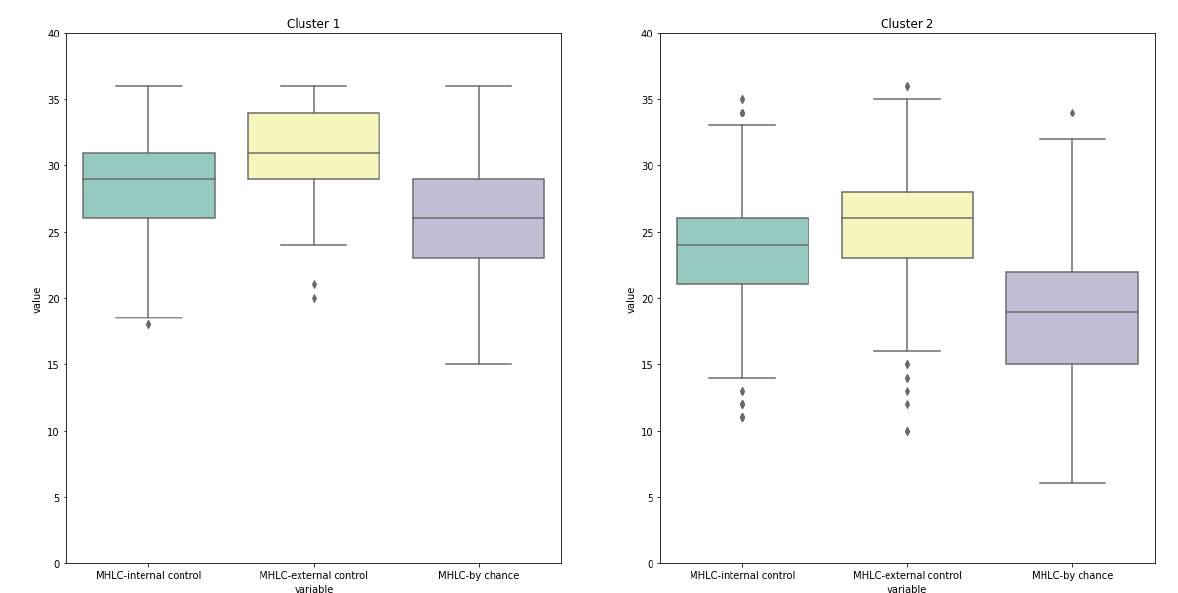
Figure 2. Distribution of 3 analyzed characteristics with 2 clusters generated by K-Means algorithm.